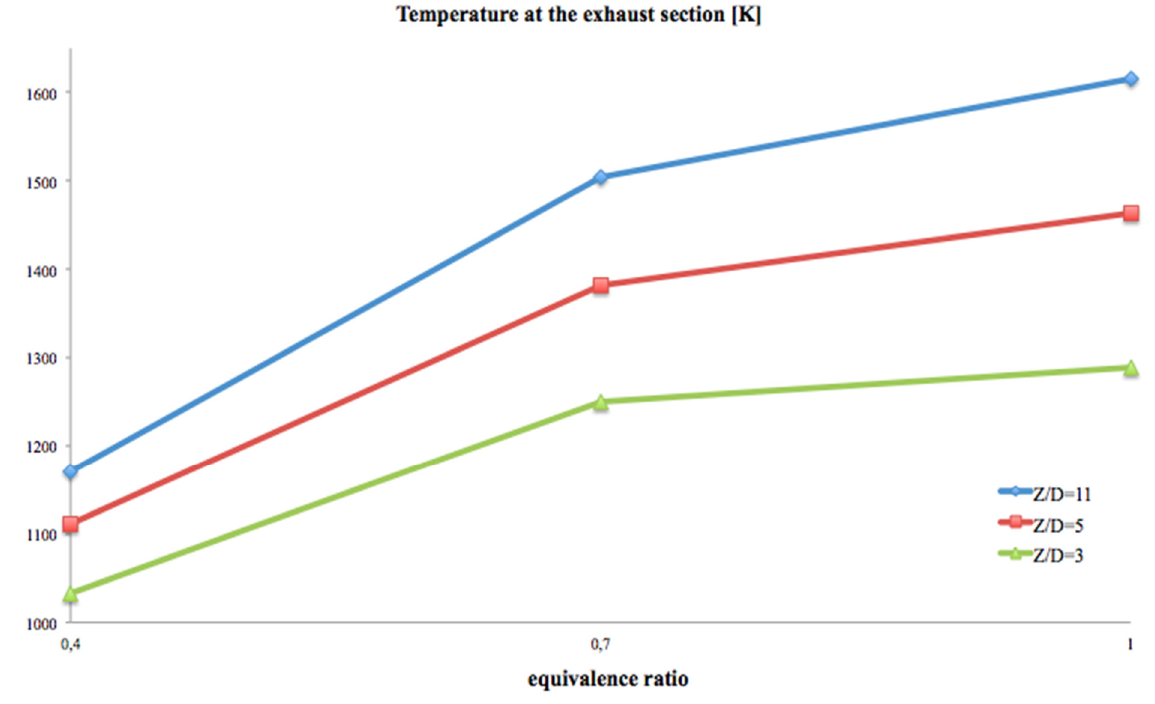
Figure 7. Average temperature at the exhaust section (K).